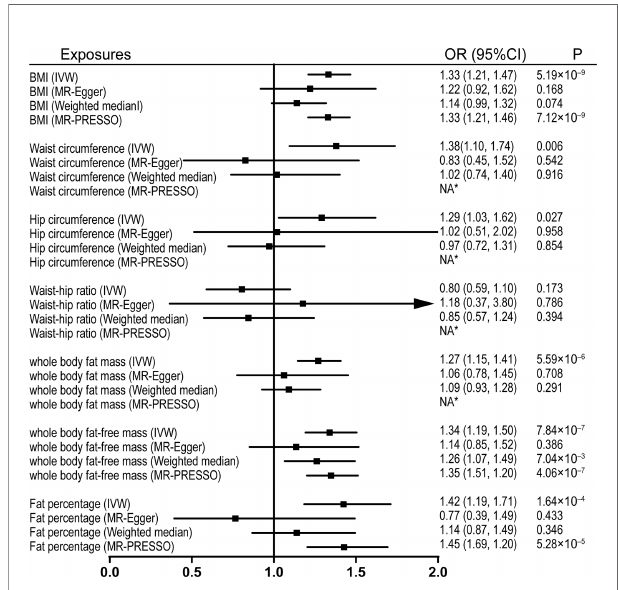
FIGURE 1 | Effects of obesity-related exposures on sciatica. Results from univariable MR analyses showing the effects of genetically proxied BMI and obesity-related traits on sciatica with IVW, MR-Egger, weighted median, and MR-PRESSO methods. *No outlier detected. IVW, inverse-variance weighted; BMI, body mass index; OR, odds ratio; CI, con fi dence interval; MR, Mendelian randomization. NA, not available.